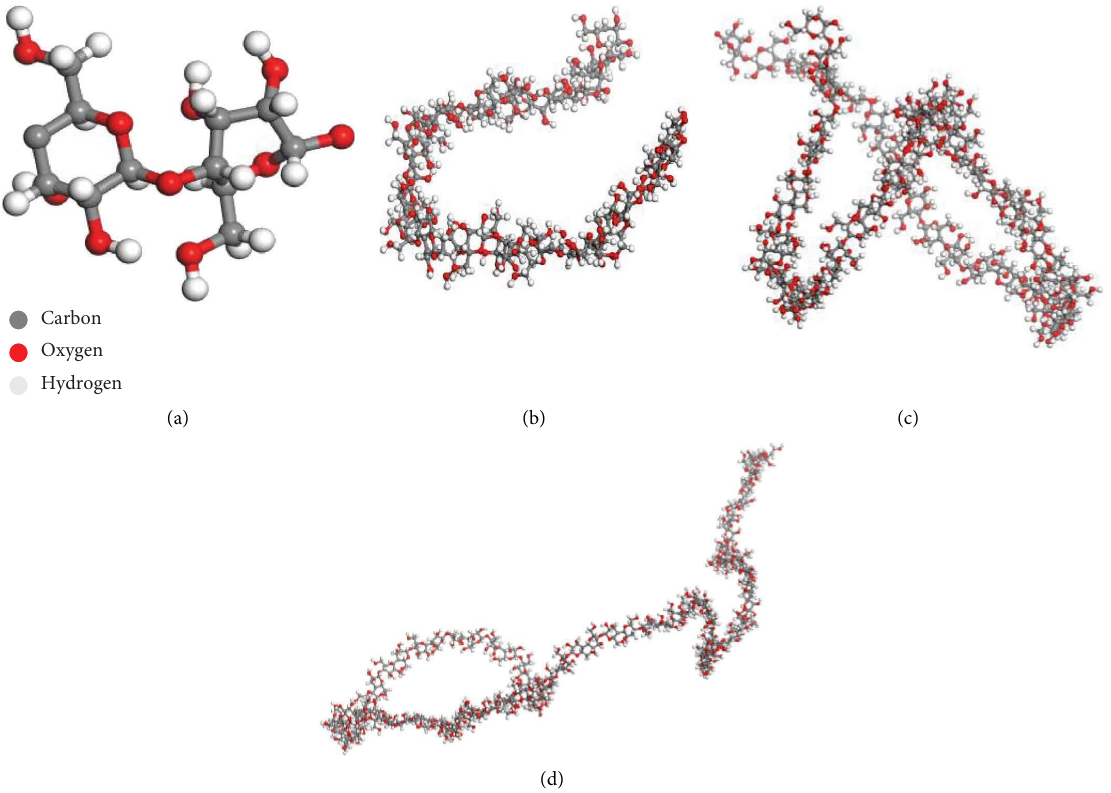
Figure 2: (a) Monomer; (b–d) cellulose chain with degree of polymerization of 15, 30, and 45.